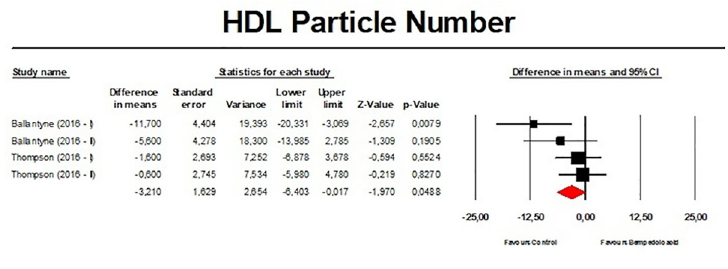
Fig 9. Forest plot displaying mean difference and 95% confidence intervals for the effect of bempedoic acid on plasma levels of high-density lipoprotein (HDL) particle number.